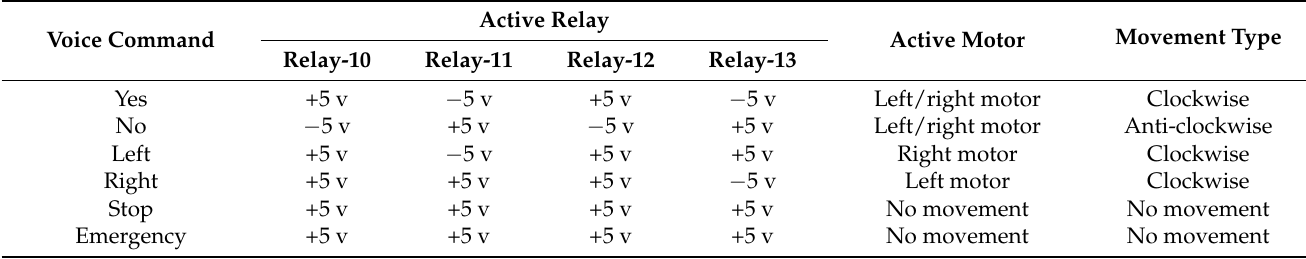
Table 2. Truth table of the wheelchair movement ( − 5 v means activate the